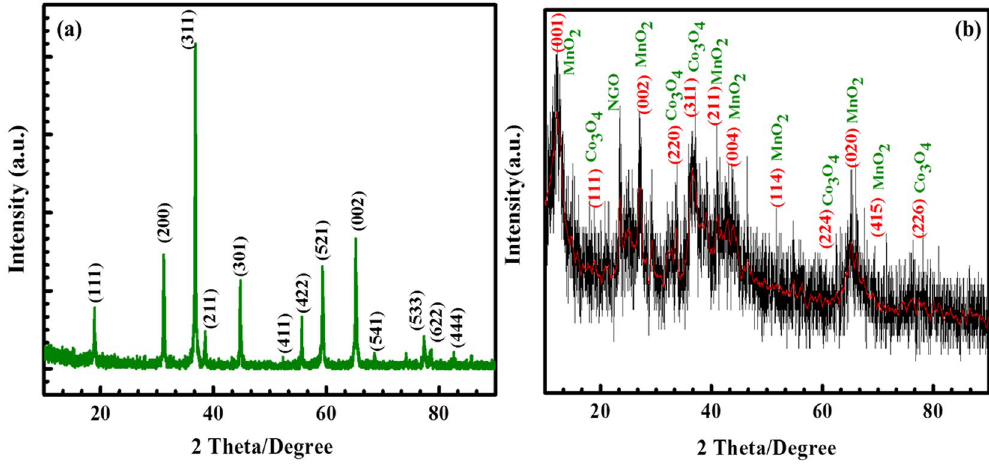
Figure 2. XRD results of ( a ) NGO/Co 3 O 4 and ( b ) Co 3 O 4 @MnO 2 /NGO hybrid